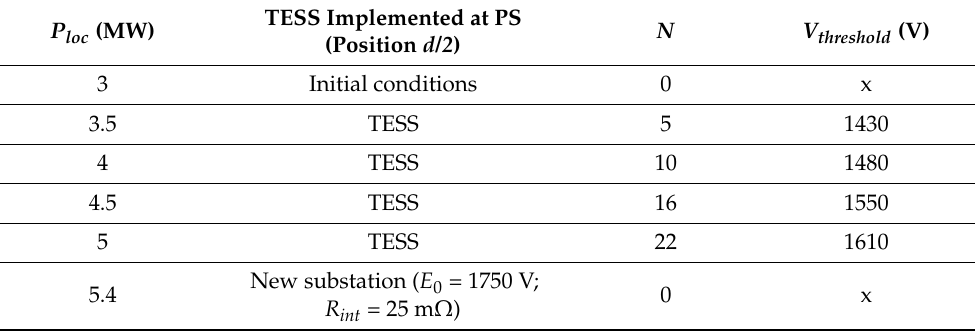
Table 5. Number of elementary blocks required to maintain a minimum pantograph voltage at 1300 V versus the power of the